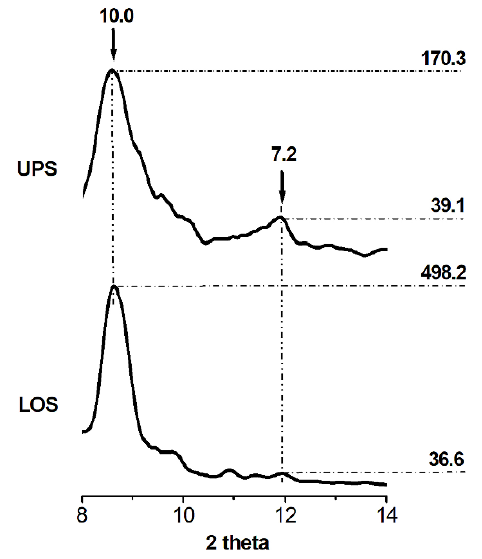
Figure 3. XRD results of the UPS and LOS samples after formamide treatment.